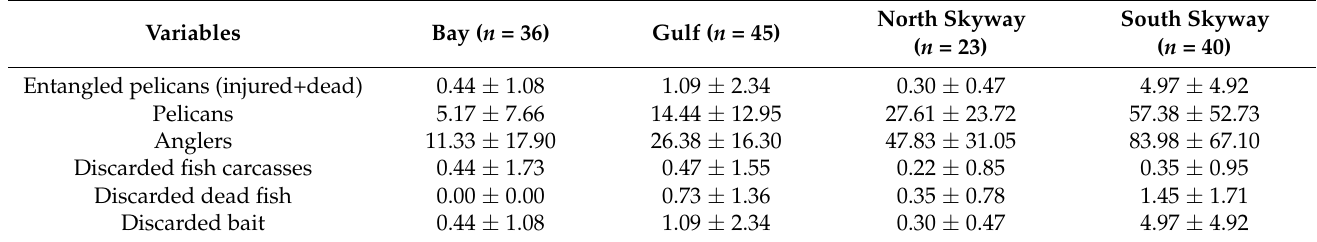
Table 1. Variables measured during each Tampa Bay, Florida, pier survey (mean ±